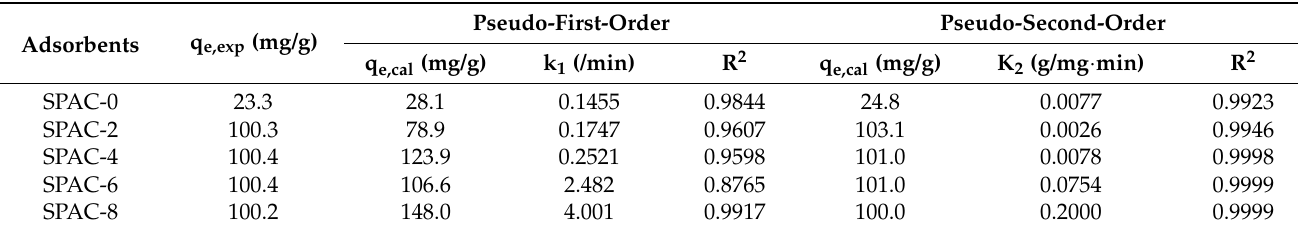
Table 1. Kinetic model parameters and correlation coefficients (R 2 ) for the adsorption of MB onto SPACs. Adsorbents q e,exp